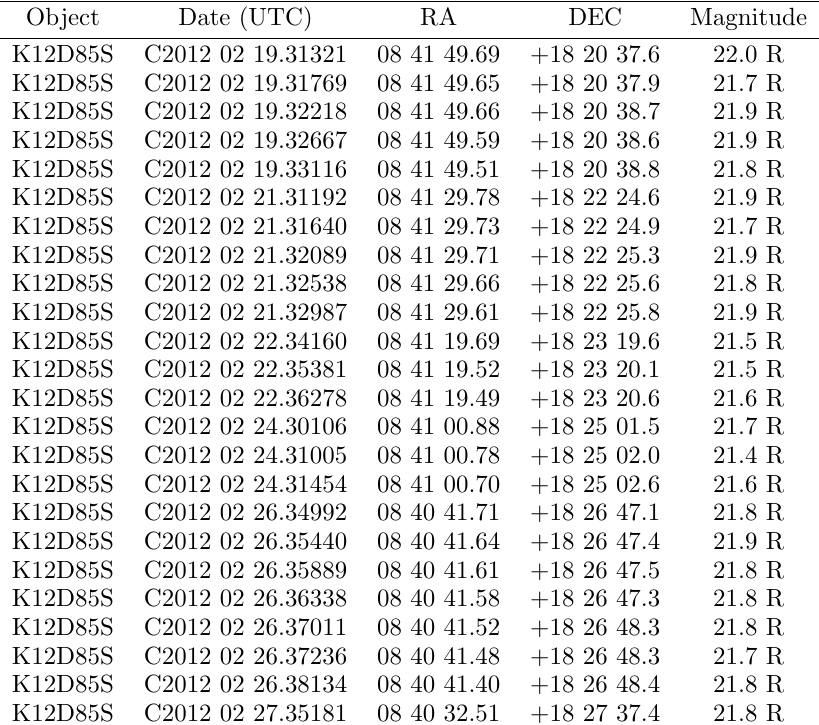
Table 6. Catalog of astrometric and photometric data for the asteroid 2012 DS85 obtained with the VATT.